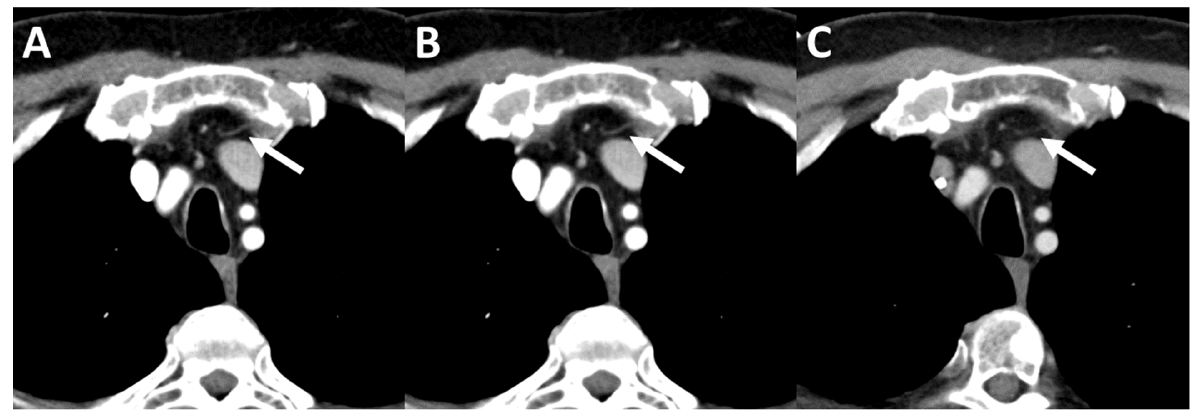
Figure 4. Delineation of mediastinal vessel contours in a 63-year-old man. Window width: 342 HU, window level: 56 HU ( A ) Q1 iterative reconstructed image data set, ( B ) Q3 iterative reconstructed image data set, ( C ) ADMIRE1 iterative reconstructed image data set. Arrows: thin mediastinal vessel.